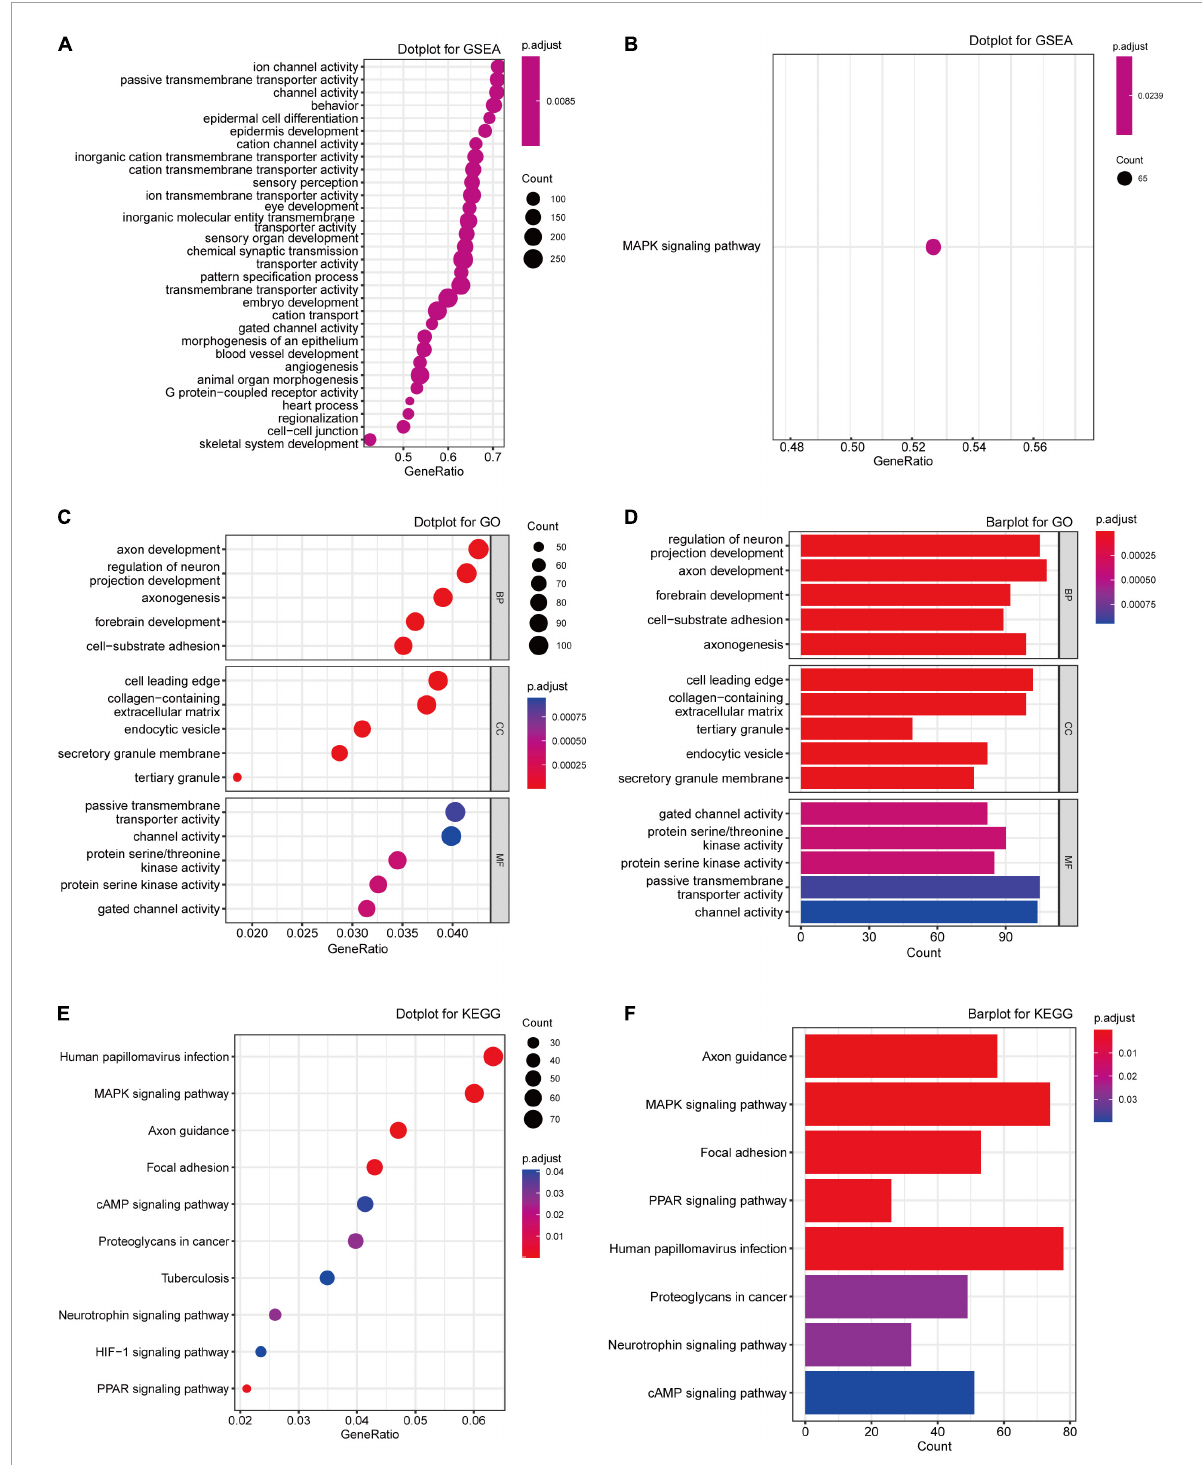
FIGURE3 Enrichment analyses of the DEGs from exprset-merged. (A,B) GSEA analysis of the DEGs from exprset-merged. (C,D) GO enrichment analyses of the DEGs. (E,F) KEGG pathway enrichment analysis of the DEGs.